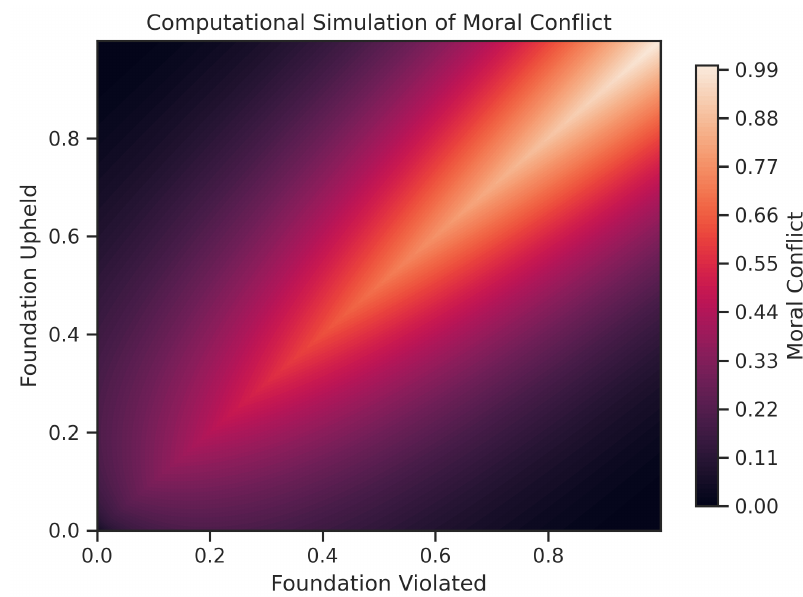
Figure 2. Computational model of moral conflict. Source: